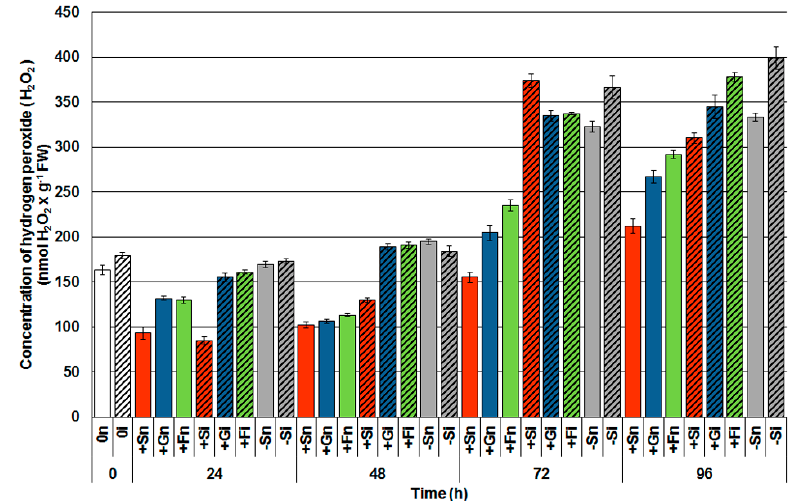
Figure 4. Effect of sucrose, glucose and fructose on the accumulation of hydrogen peroxide (H 2 O 2 ) in in vitro cultured embryo axes of Lupinus luteus infected with Fusarium oxysporum f. sp. lupini . A summary of the statistical significance of differences between the average values of each pair at p < 0.05 can be found in the Supplementary Files (Table S6). p < 0.05 can be found in the Supplementary Files (Table